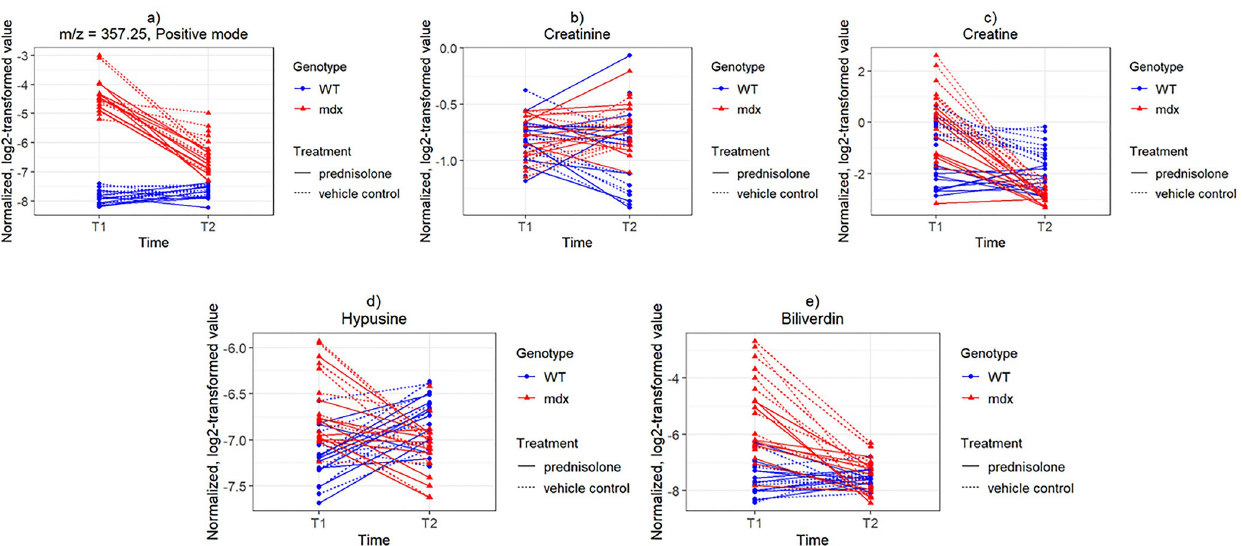
Fig 5. Normalized, log2-transformed intensity values at times T1-T2. a) peak with m/z = 357.25 in positive mode, b) creatine (m/z = 132.08 in positive mode), c) creatinine (m/z = 114.06 in positive mode), d) hypusine (m/z = 234.18 in positive mode), e) peak likely to be biliverdin (m/z = 583.26 in positive